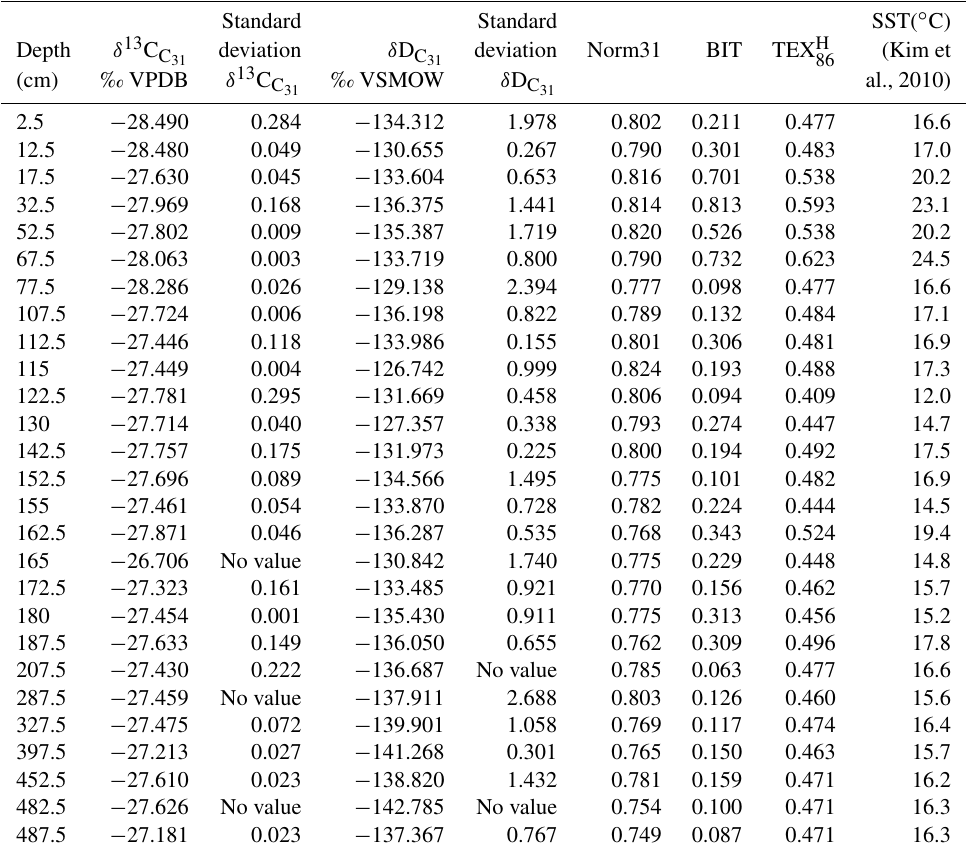
Table 3. GeoB18308-1 organic geochemical down-core data. n -Alkane isotopic composition and distribution descriptive parameters averaged (with standard deviation), BIT, TEX H and SSTs ( ◦ C) calculated from TEX H after Kim et al. 86 86